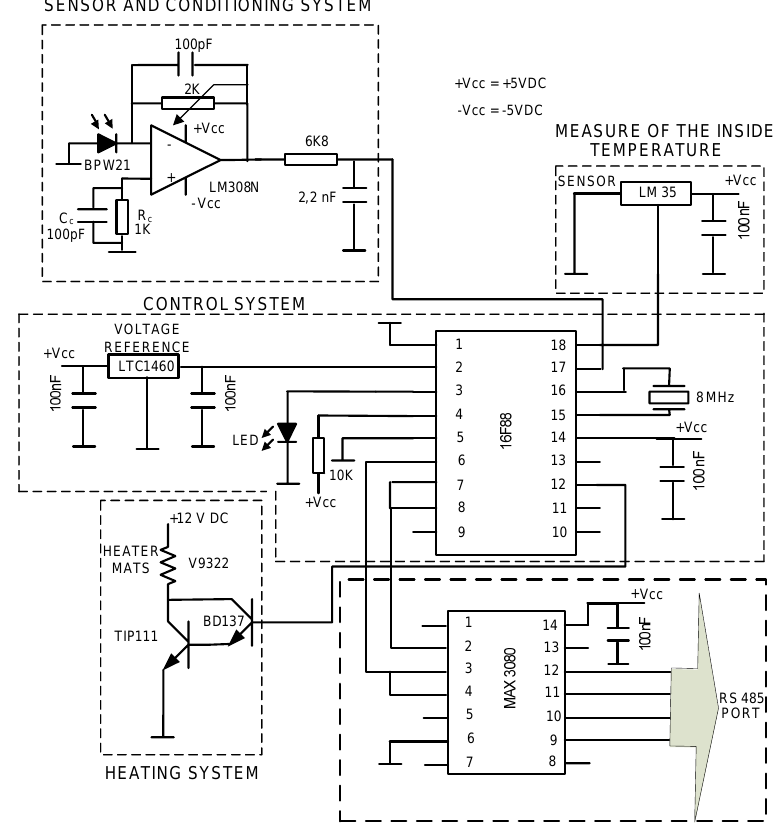
Figure 2. Pyranometer circuit